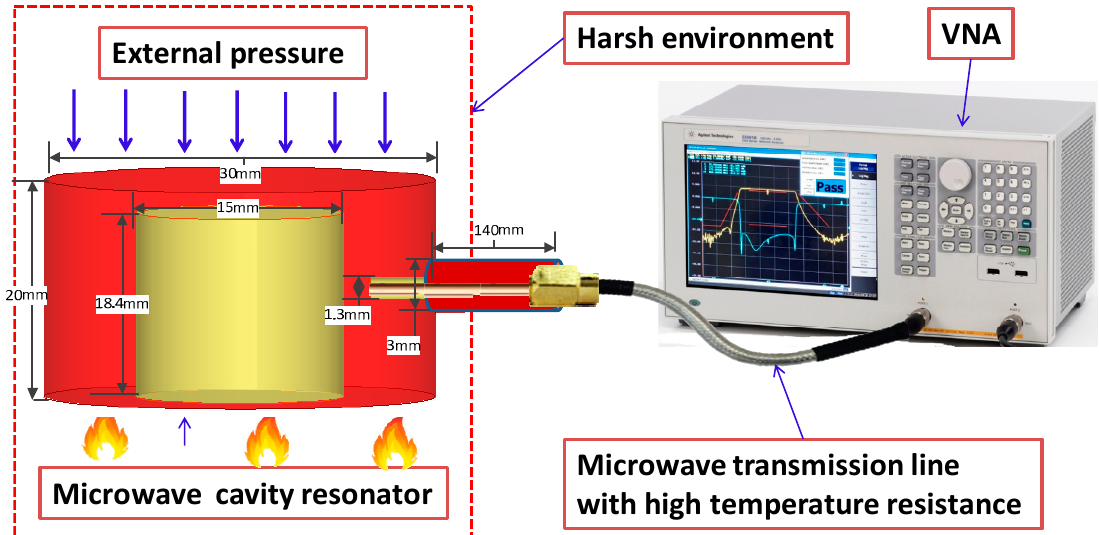
Figure 1. Schematic of the wire interrogation, in-situ pressure-monitoring configuration used in high-temperature environments.